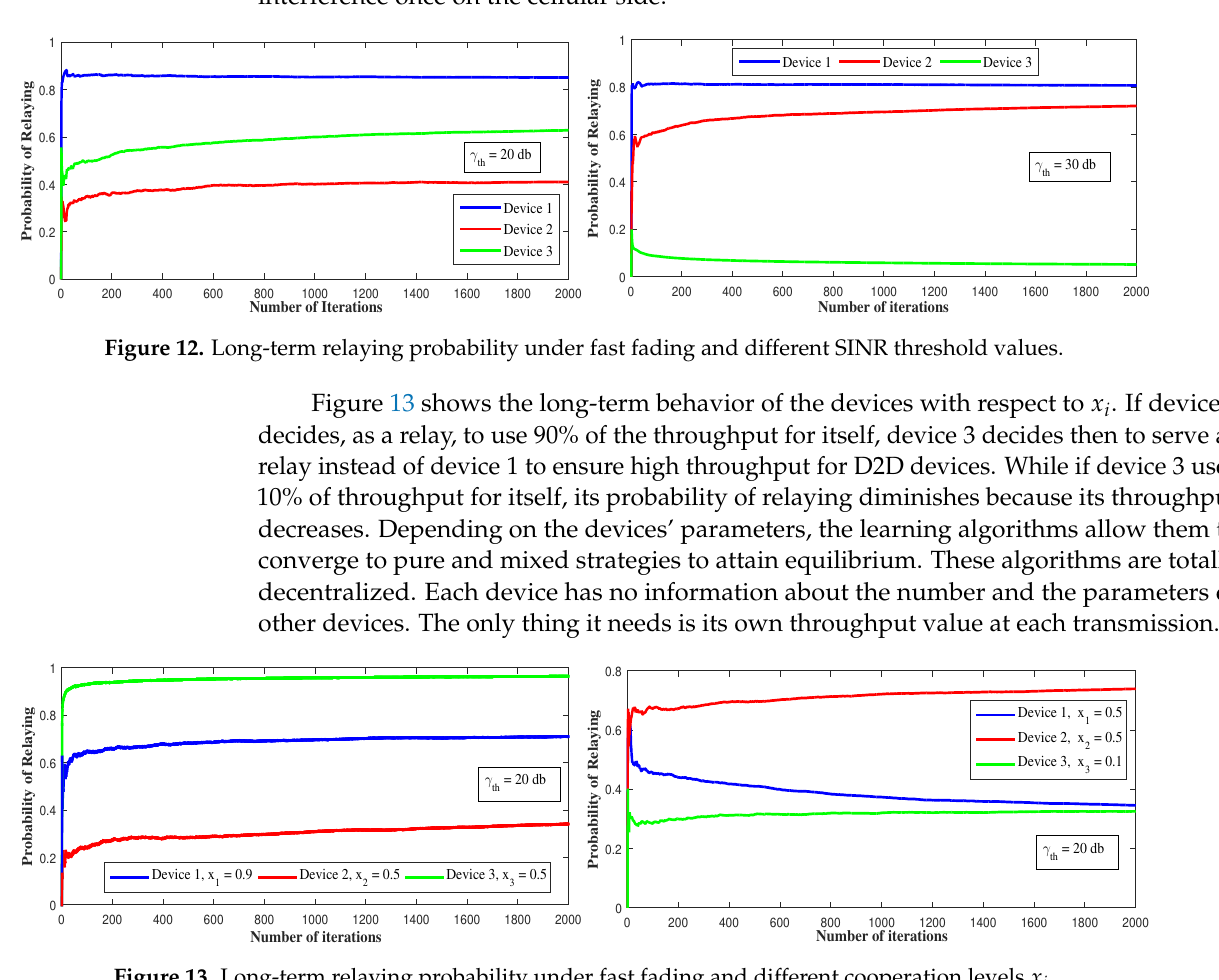
Figure 13. Long-term relaying probability under fast fading and different cooperation levels x i